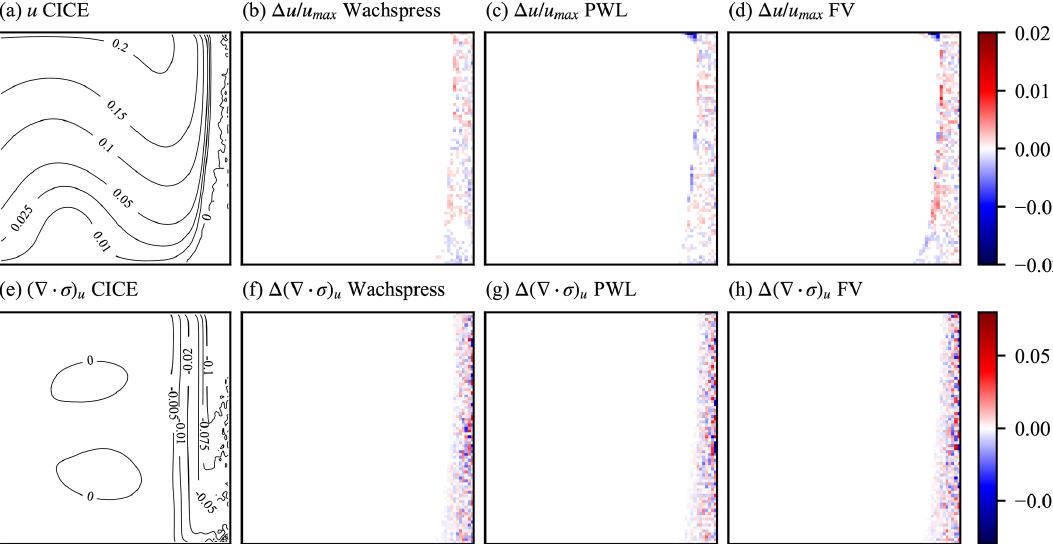
Figure 12. (a) The u velocity component of CICE for the square domain test case using a quadrilateral mesh. (b, c, d) Difference ( (cid:49)u/u max ) between the u component of MPAS-Seaice and CICE in the square domain test case for the MPAS-Seaice Wachspress variational, PWL variational, and finite-volume (FV) schemes, respectively, and using a quadrilateral mesh. (e) – (h) As (a) – (d) but for the u component of the divergence of internal ice stress.